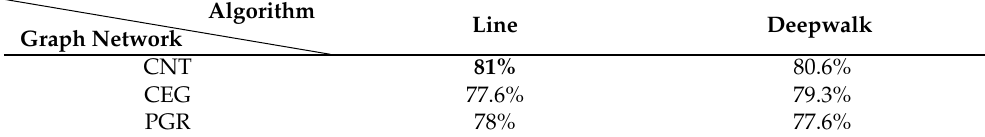
Table 3. Results on the COPA-Test . Graph Network